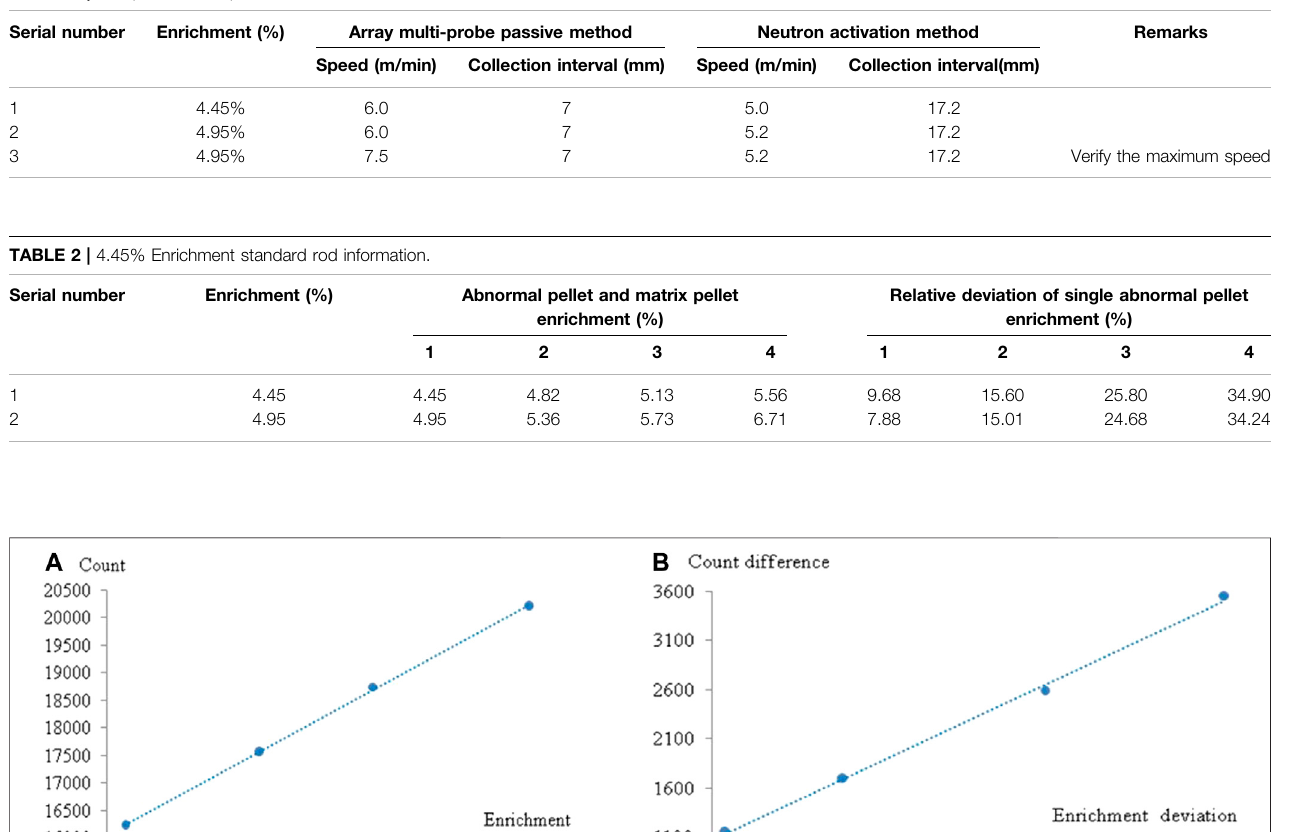
TABLE 1 | Comparative test parameters.